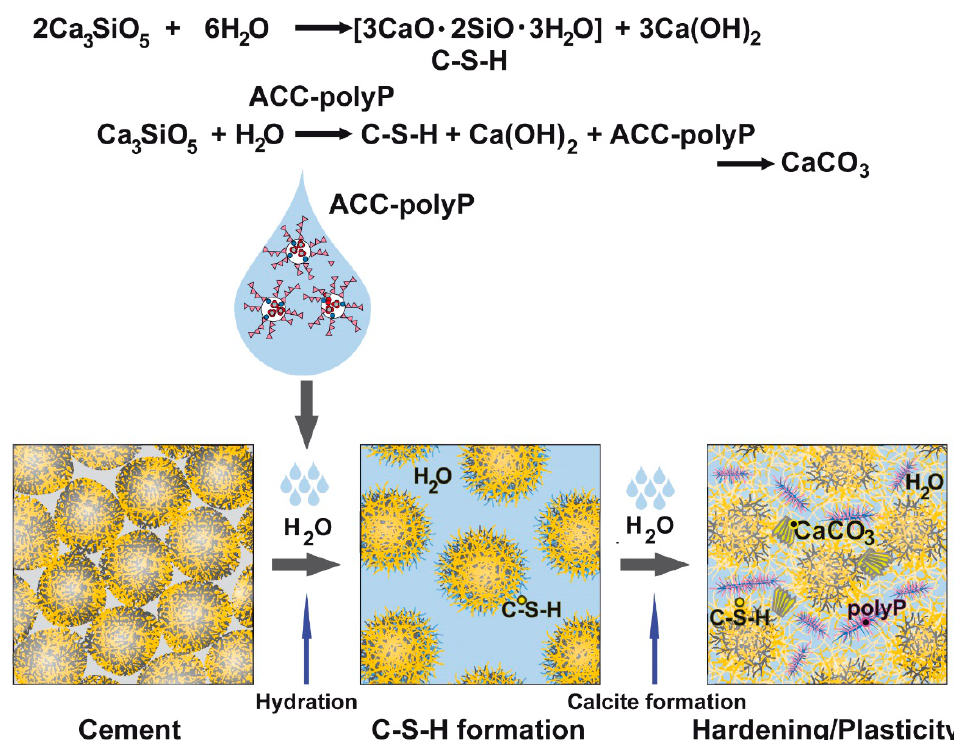
Figure 13. Schematic outline of the process of calcite formation in cement containing “ACCP10”. Both in the absence of “ACCP10”, in “hCEM” and in its presence, in “hCEM • ACCP10”, Ca 3 SiO 5 undergoes a transformation into C–S–H in water under the release of calcium hydroxide turning the material into an alkaline paste. In the presence of “ACCP10” [ACC-polyP], in “hCEM • ACCP10”, calcite is additionally formed, turning the cement into a hard and a likewise more flexible material.